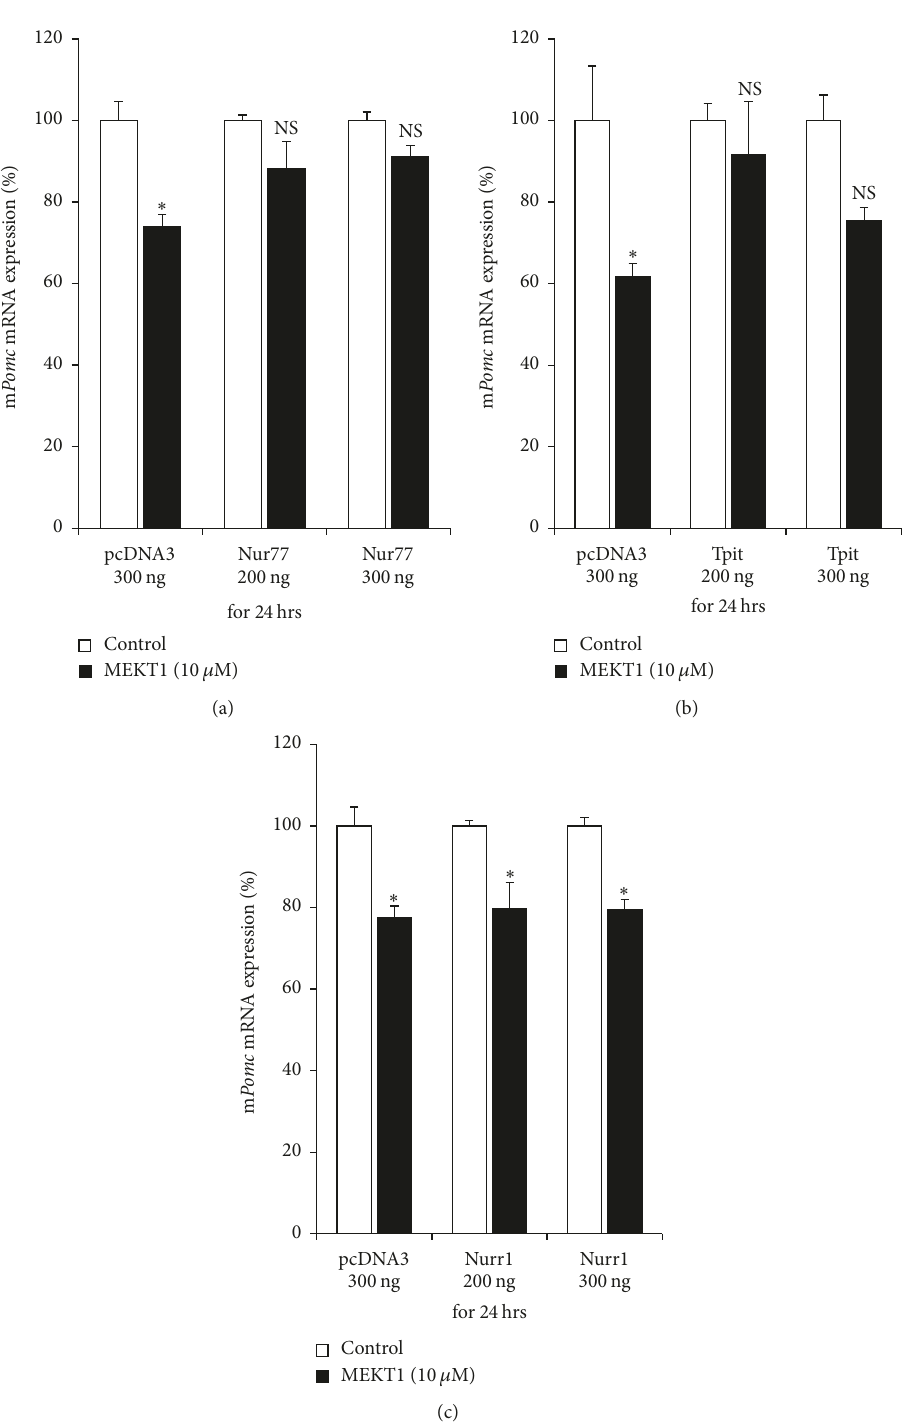
Figure 9: Effects of Nur77, Tpit, and Nurr1 overexpression on MEKT1-mediated effect of Pomc mRNA expression. (a) Nur77 overexpression effect on the MEKT1-mediated suppression of Pomc mRNA expression in AtT20 cells. AtT20 cells transiently transfected with pcDNA3 and Nur77 overexpression plasmid were incubated either in the presence of MEKT1 at 10 𝜇 M or DMSO at 0.1% (control) for 24 hours. (b) Tpit overexpression effect on the MEKT1-mediated suppression of Pomc mRNA expression. AtT20 cells transiently transfected with pcDNA3 and Tpit overexpression plasmid were incubated either in the presence of MEKT1 at 10 𝜇 M or DMSO at 0.1% (control) for 24 hours. (c) Nurr1 overexpression on the MEKT1-mediated suppression of Pomc mRNA expression. AtT20 cells transiently transfected with pcDNA3 and Nurr1 overexpression plasmid were incubated either in the presence of MEKT1 at 10 𝜇 M or DMSO at 0.1% (control) for 24 hours. Each overexpression plasmid volume was maintained to 300 ng adding pcDNA3 empty vector. Results are expressed as percentages (100%) of control. Data represent mean ± SEM ( 𝑛 = 4 ). NS stands for “not significant.” ∗ 𝑃 < 0.05 , versus